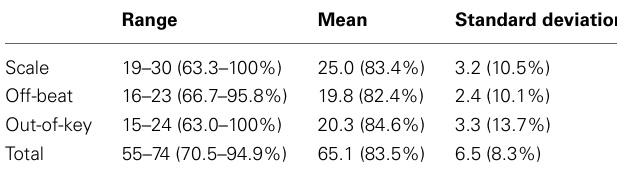
Table 3 | Basic descriptive statistics of the music perception test.